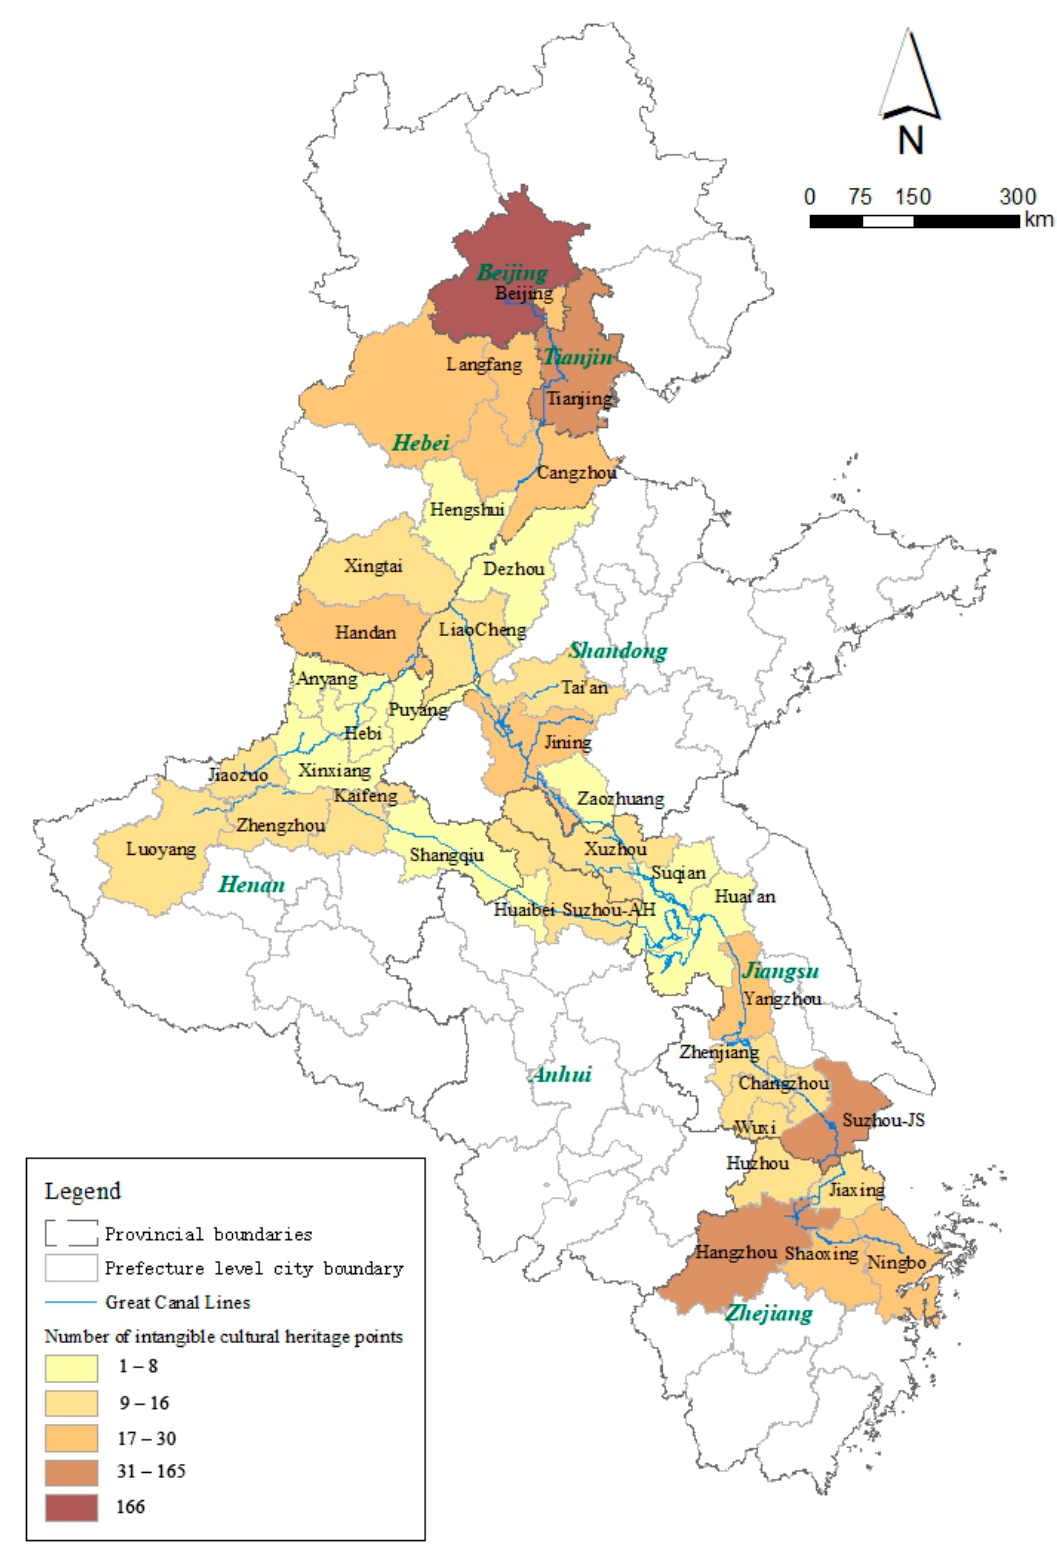
Figure 3. The distribution of intangible cultural heritage (ICH) resources along the Grand Canal.